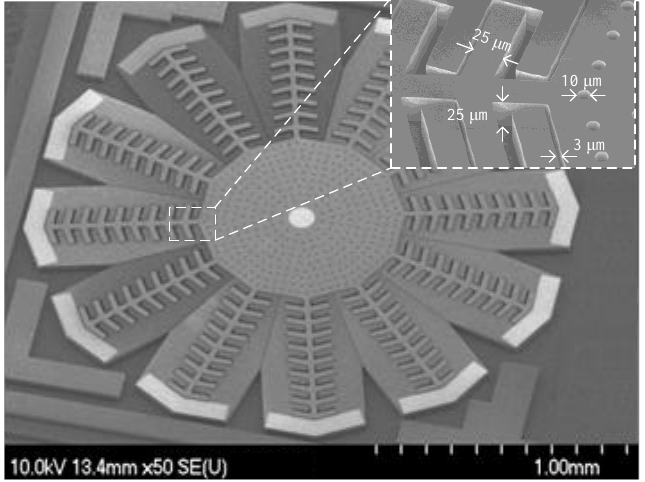
Figure 11. SEM micrograph of a fabricated device with zoomed view of the comb